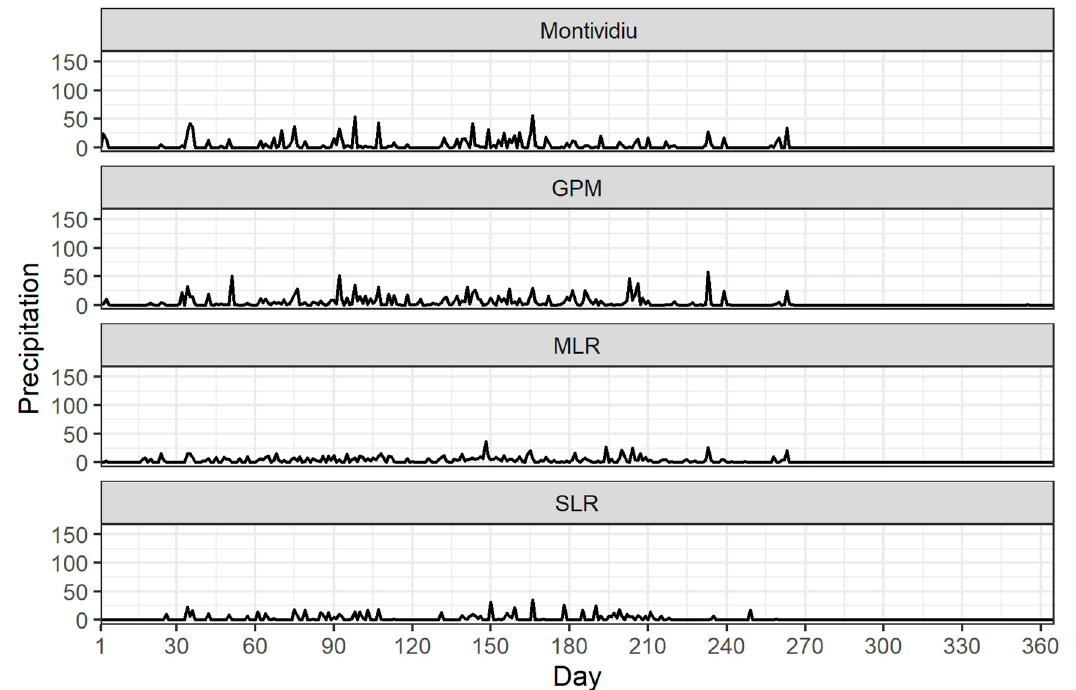
Figure 8. Direct comparisons between daily precipitation estimates and observed data for the period from 1 September 2016 to 31 August 2016 at the Montividiu station. OBS, observed data; MLR, multiple linear regression method; SLR, simple linear regression; GPM, Global Precipitation Measurement method.